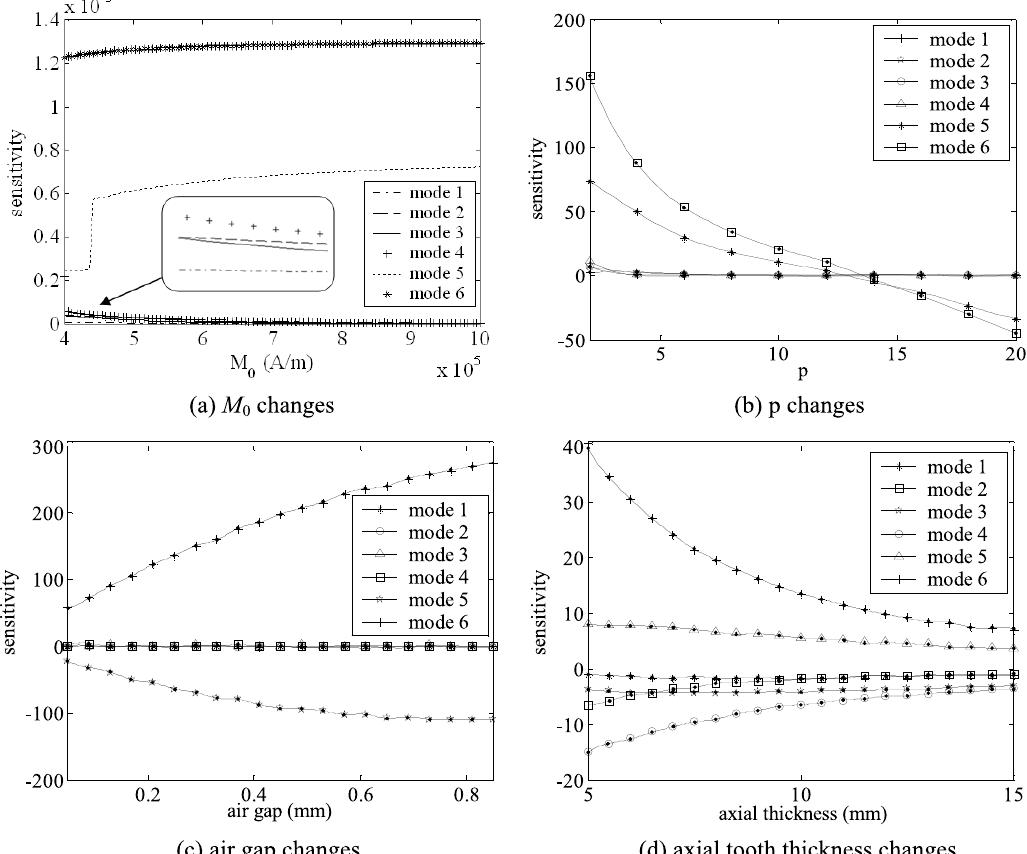
Fig. 11. Sensitivity to the system parameters for the translation modes of the central